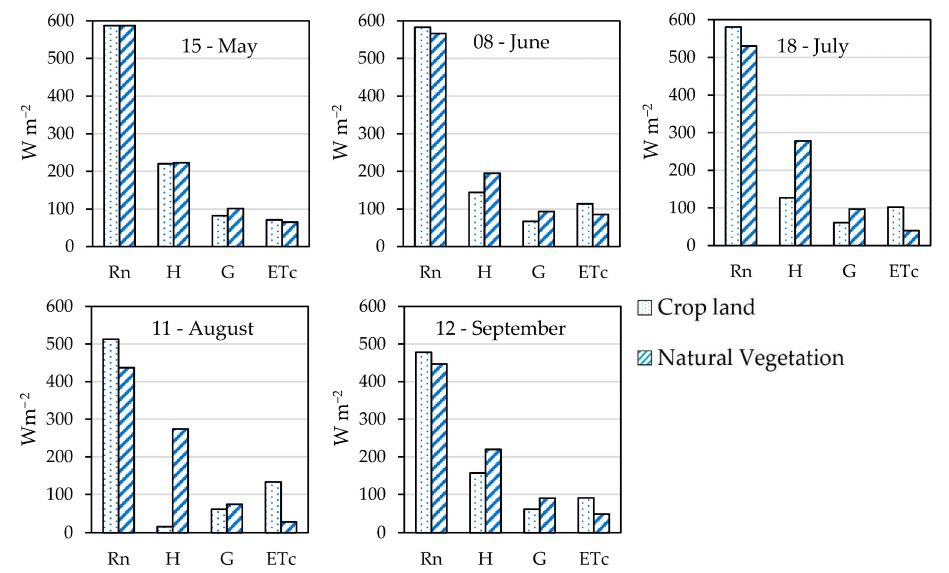
Figure 12. Comparison of METRIC estimated surface energy balance fluxes between cropland and natural vegetation across the study area during the 2018 growing